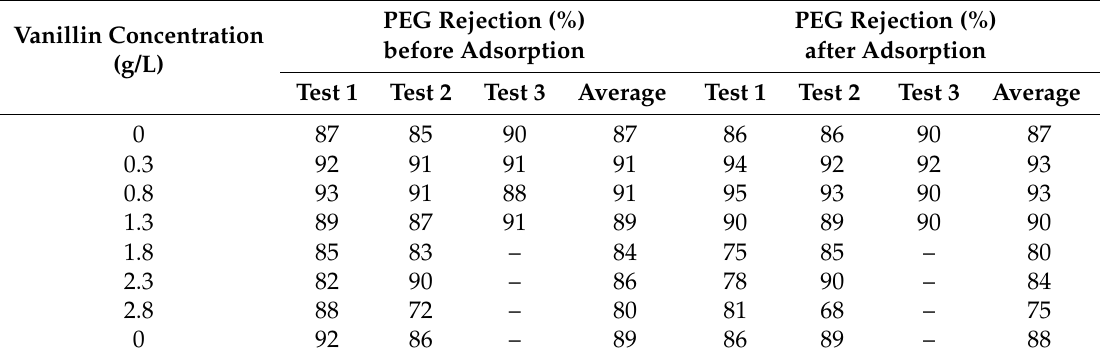
Table 5. PEG rejection before and after exposure of membranes to different vanillin concentrations at the pH